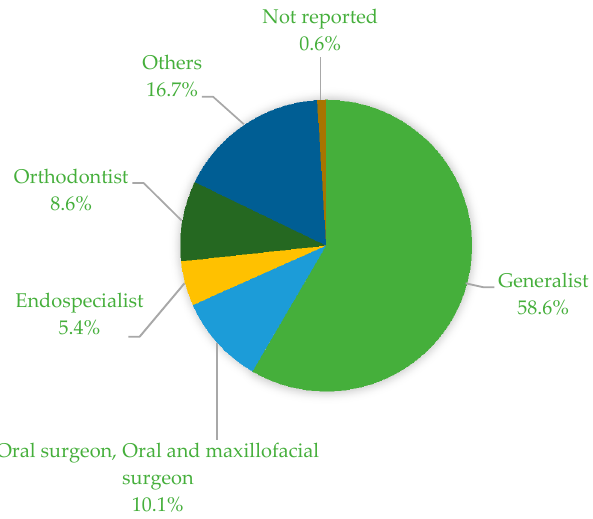
Figure 1. Distribution of the area of their employers’ specialization of the study population (in %).